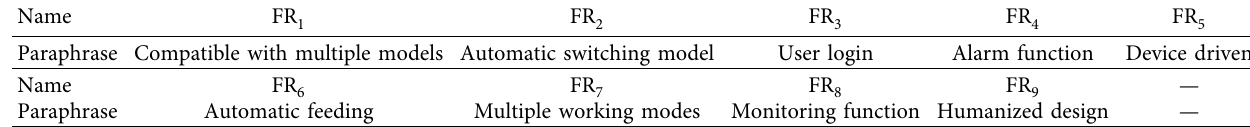
Table 8: Functional characteristics of the control service